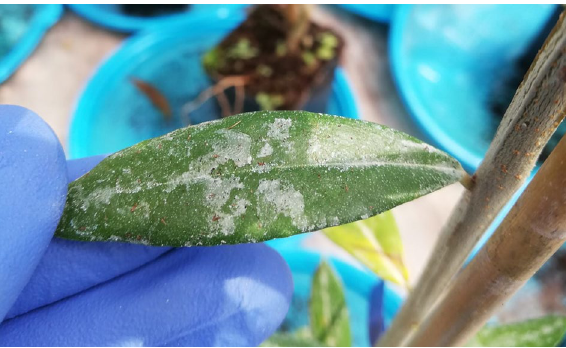
Figure 6. Observed patina on leaves treated with 1% w/v CNCs suspension.